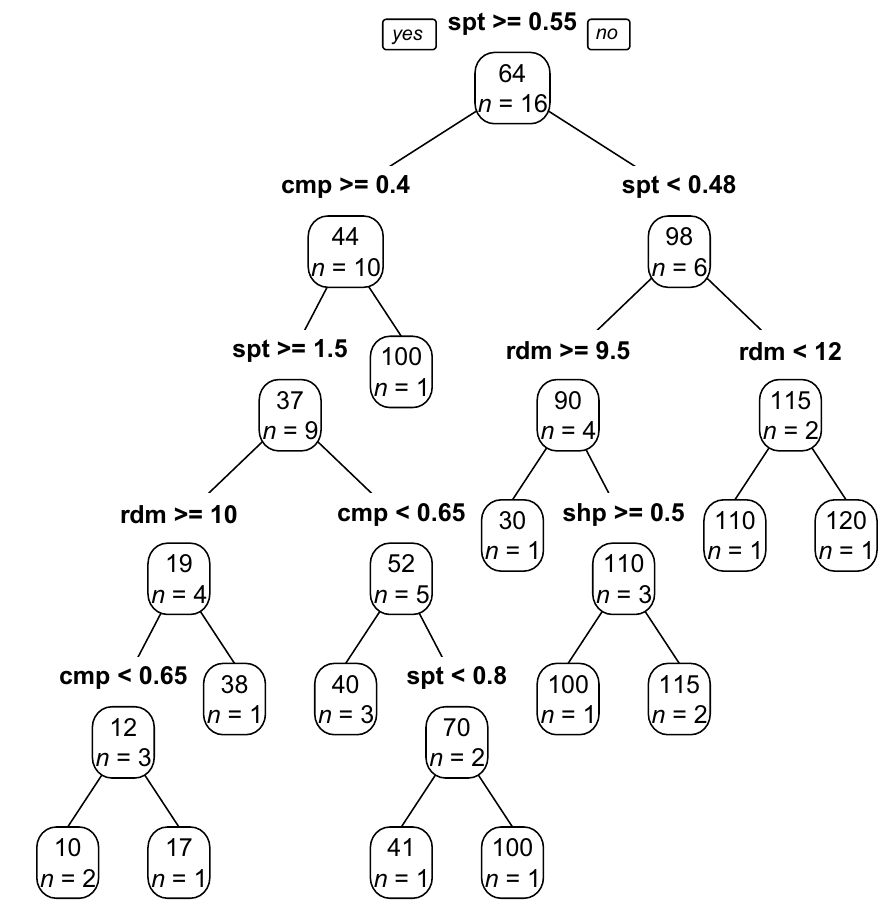
Figure A7. Graphical representation of the rulesets of the RT model established for the water class. Note: spt = spatial resolution, rdm = radiometric resolution, shp = shape/color weight, and cmp = compactness/smoothness weight, n = the number of samples at each node; the values in the rectangles are the estimated SPs.